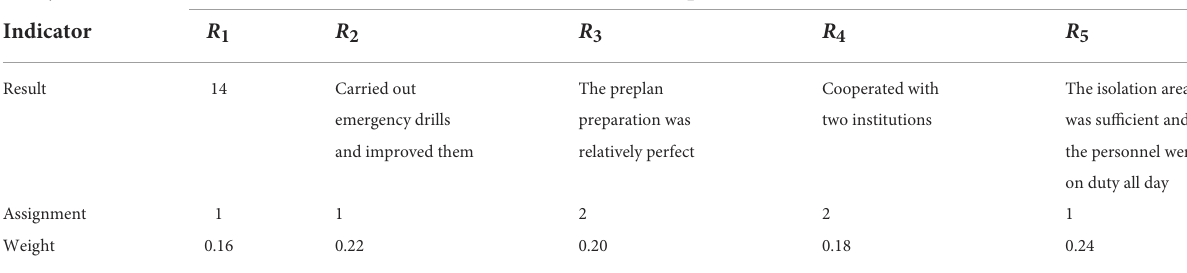
TABLE 5 Epidemic risk index collection—response system for university resumption.